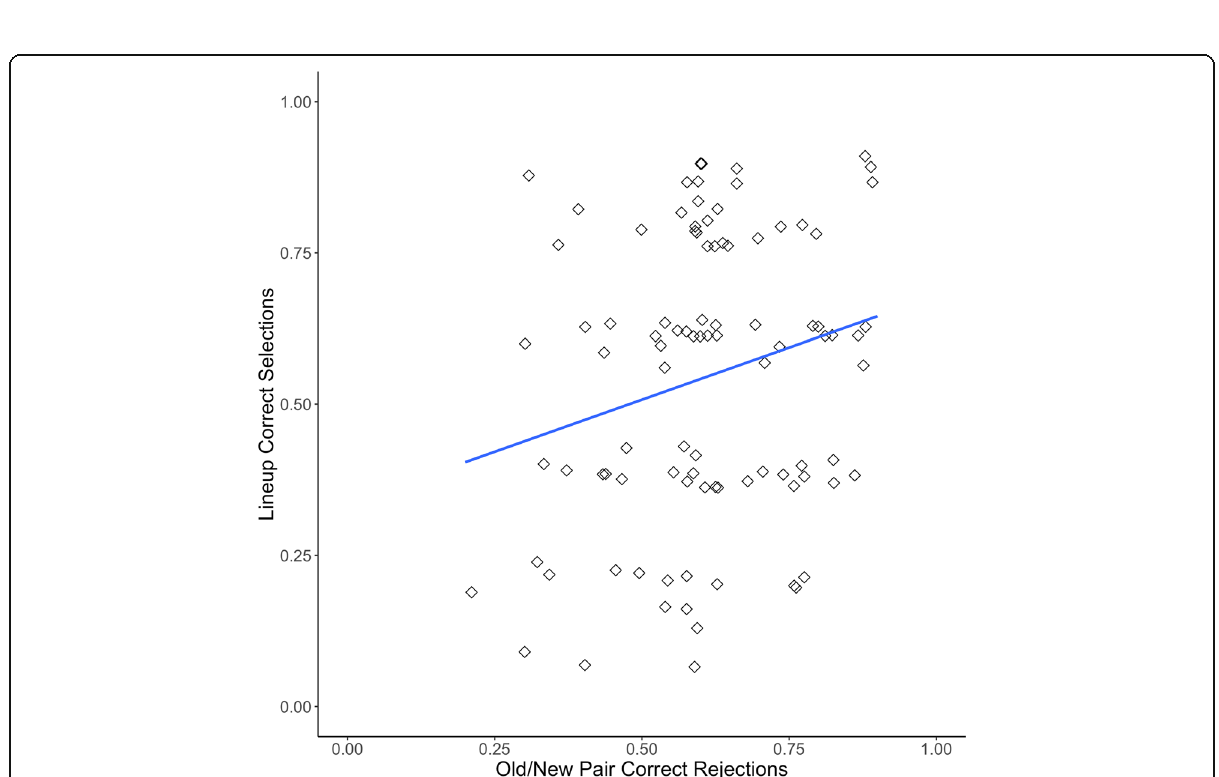
Fig. 3 Face recognition skill correlation for Experiment 1 with linear trendline, both axes